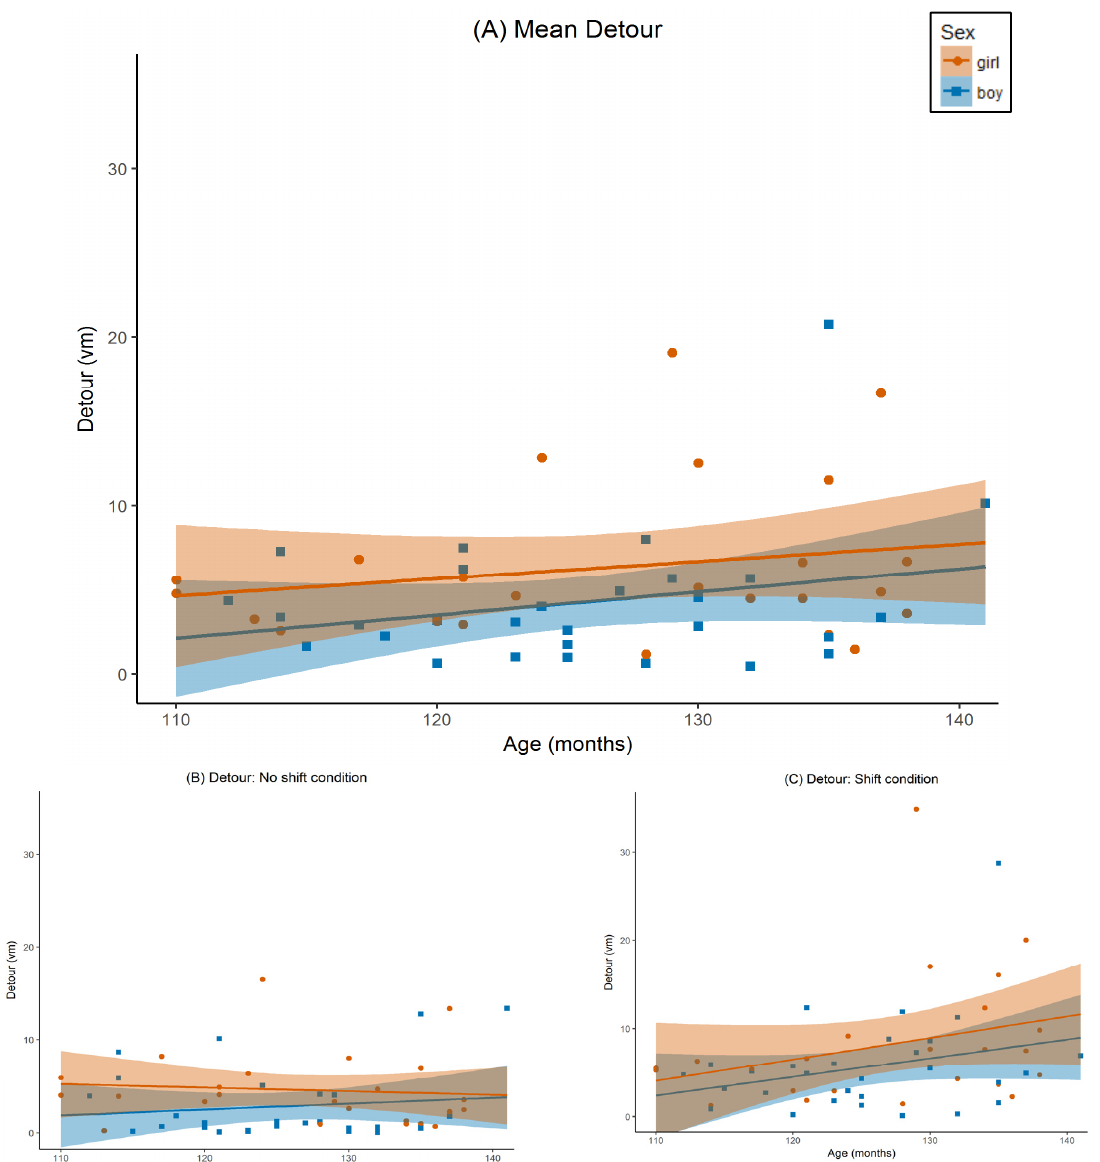
Figure 5. Detour by age for boys and girls. Detour was measured as the walked virtual meters (vm) by the player in the testing phase minus the length in vm of the shortest path between the start and end position of the player in the testing phase. Age was measured in months. The graph is separated by sex: orange circles represent girls, blue squares represent boys. Lines represent the regression line, separated by sex (orange for girls, blue for boys). The shaded area around the regression line represents the standard error. ( A ) Mean Detour over both trial types (‘no shift’ and ‘shift’). ( B ) Detour for the ’no shift’ condition. ( C ) Detour for the ‘shift’ condition.